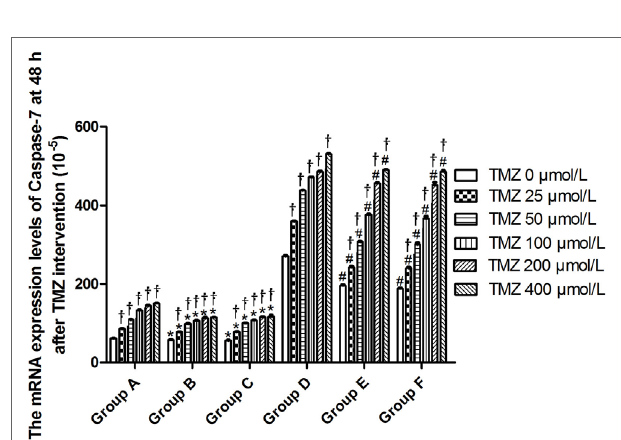
FigUre 6 | The mRNA expression levels of Caspase-7 at 48 h after temozolomide (TMZ) intervention (10 − 5 ). * P < 0.05, compared with Group A in the same concentration; † P < 0.05 compared with the concentration of 0 µmol/L; # P < 0.05 compared with Group D in the same concentration. Group A: TJ905 cells transfected with Livin-shRNA, Group B: TJ905 cells transfected with negative-shRNA, Group C: the monolayer culture of TJ905 glioma cells, Group D: glioma stem cells transfected with Livin-shRNA, Group E: glioma stem cells transfected with negative-shRNA, and Group F: the monolayer culture of TJ905 glioma stem